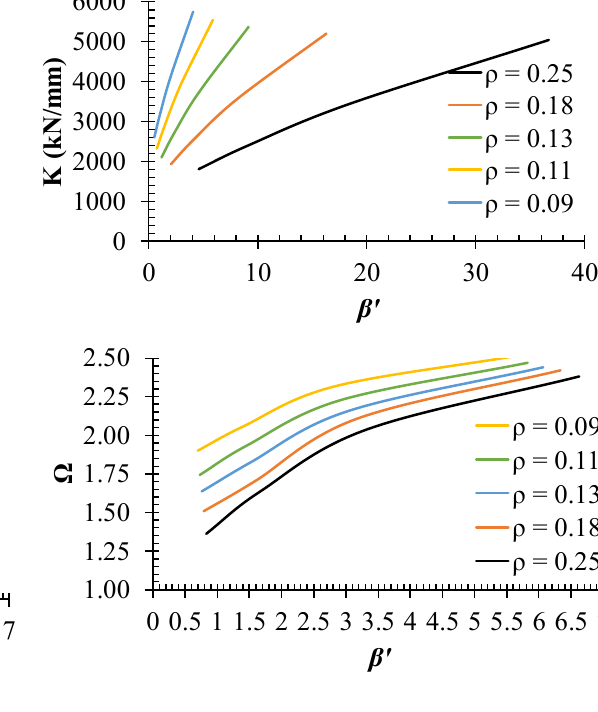
Figure 7. F u , K , V s , and Ω versus β’.